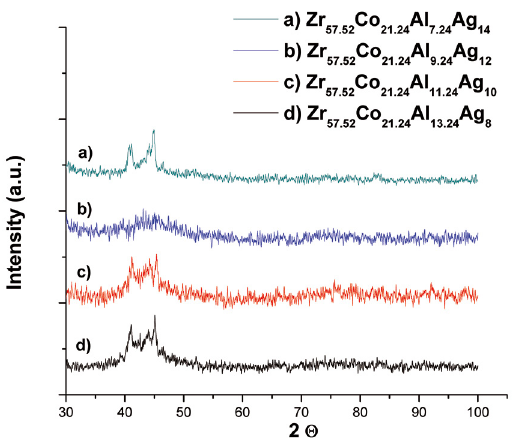
Figure 3: XRD patterns for Zr-Co-Al-Ag alloys of 2 mm cross-section. Figure 4 shows an elemental EDS mapping taken